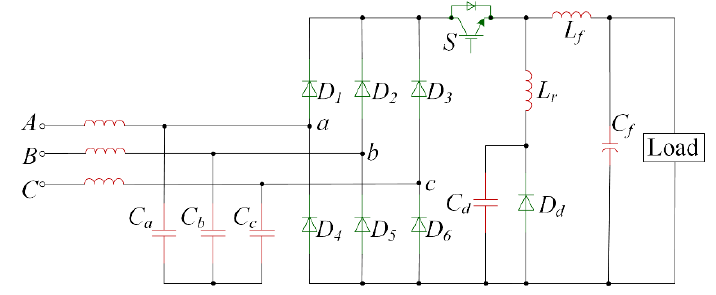
Figure 3. New three-phase multi-resonant zero-current-switching buck